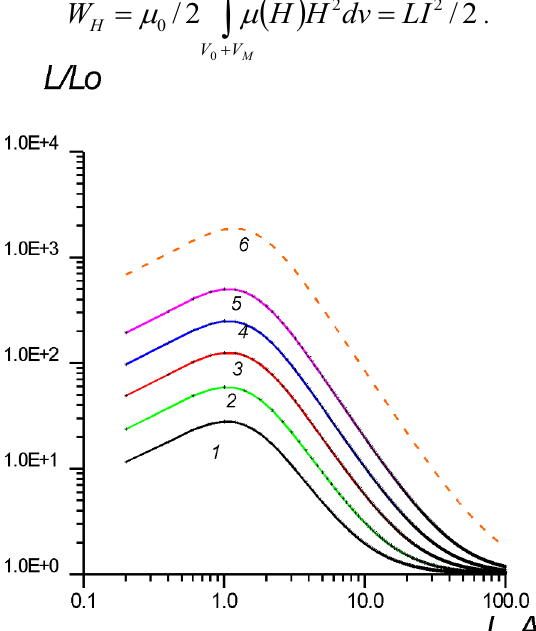
Fig. 2. The dependence of L/L 0 of the coil current I (A) at different angles of filling the volume by screen material: φ = π / 2, t =8 (1), 16 (2), 32 (3) mm; t= 32, φ = π (4) φ = 2 π (5); φ =2 π , t =100 mm